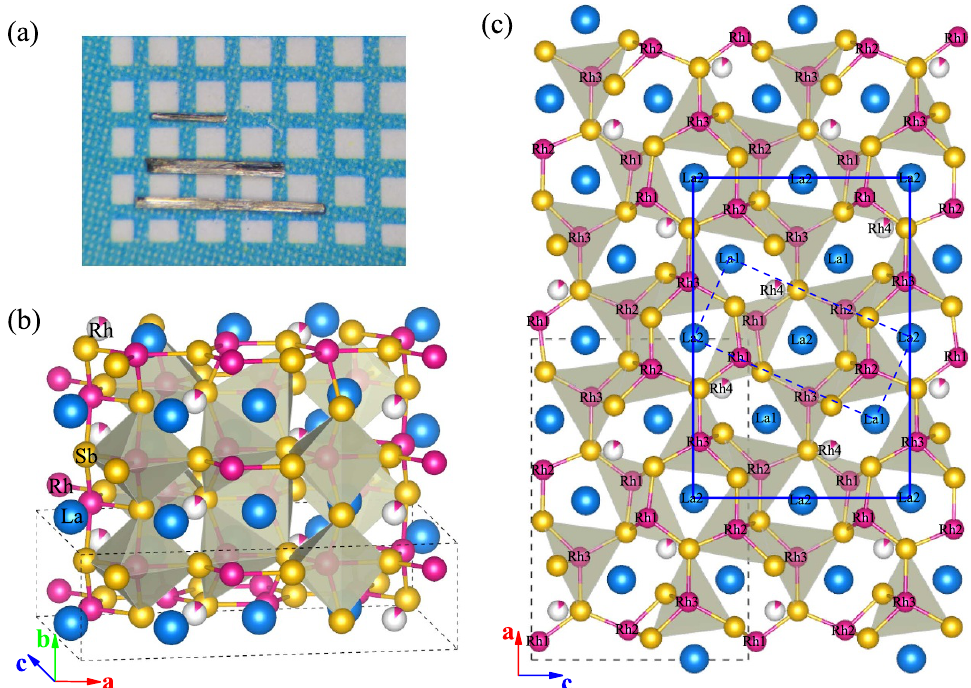
Figure 1. (a) A photograph of La 2 Rh 3 + δ Sb 4 single crystals on millimeter-grid paper. The single crystals are needle-like along b axis. Figures (b)–(c) show the crystalline structure. The partially occupied Rh4 is double-colored. The black-dotted rectangles mean the original unit cell as determined by XRD refinement. To better compare the crystalline structure to the STEM image, a translated unit cell is also shown by the blue-solid rectangle. The blue-dashed rectangular shows the part that mimics the distorted CaBe 2 Ge 2 -type structure.